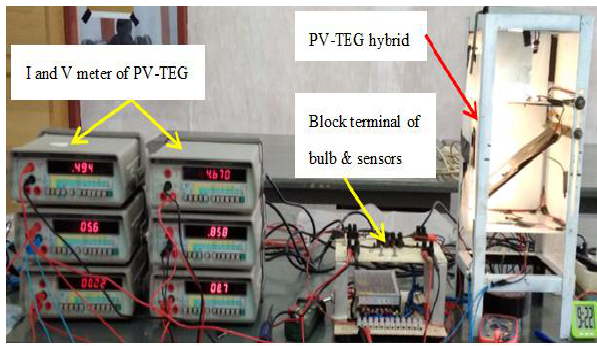
Figure 2. Photograph of the complete experimental of PV-TEG hybrid setup. Table 1. Specifications of GW Instek GDM-8135 Digital